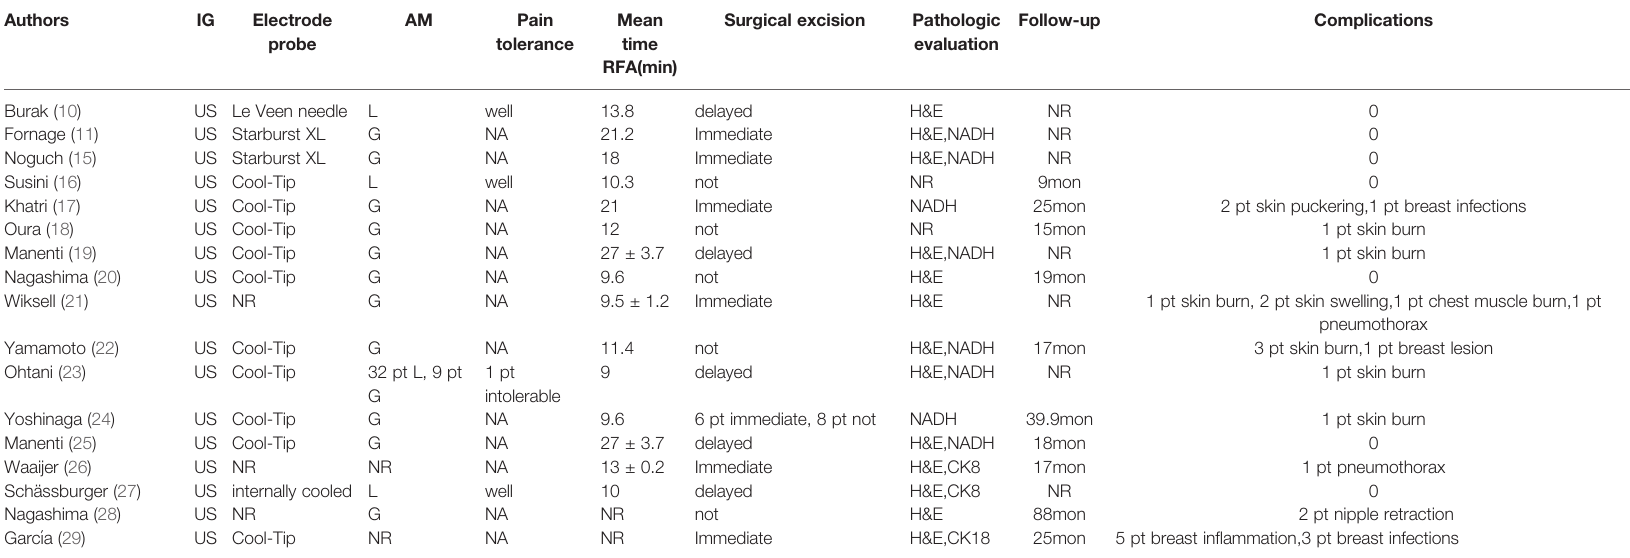
TABLE 2 | The treatment characteristics and complications of radiofrequency ablation in the trials. Authors IG Electrode